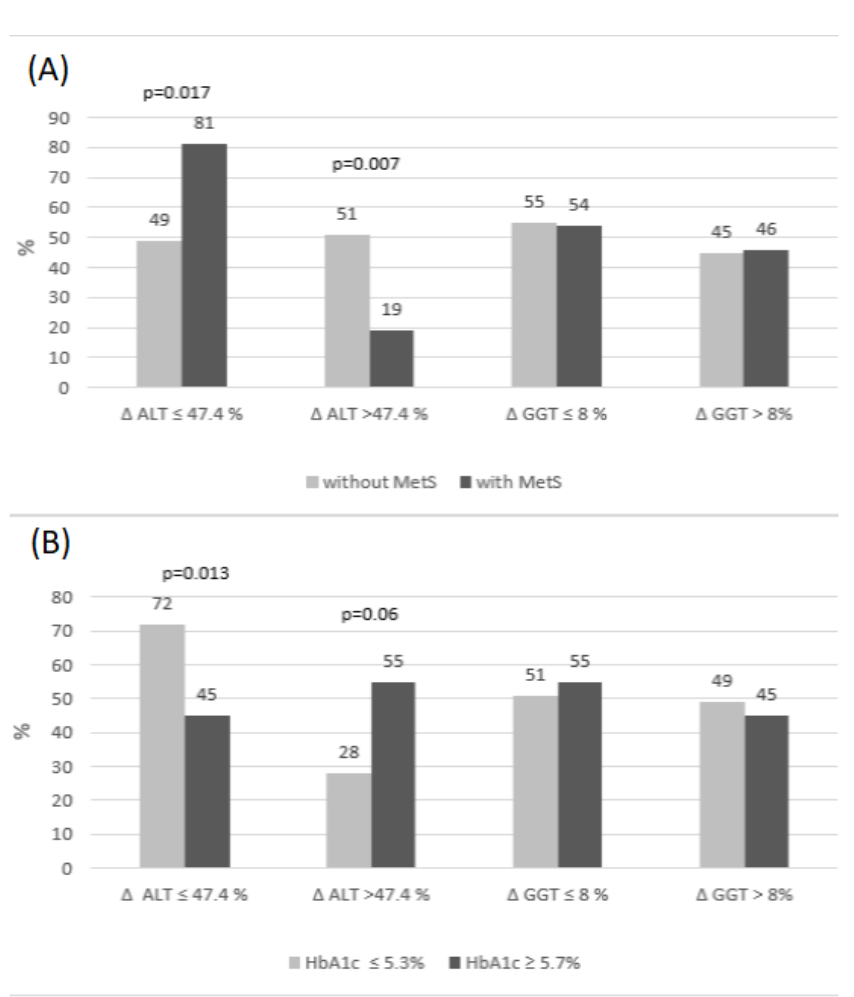
Figure 1. The percentage of deltas below and above RCV for GGT and ALT in the subgroups with/without MetS ( A ) and elevated/desirable HbA1c ( B ).